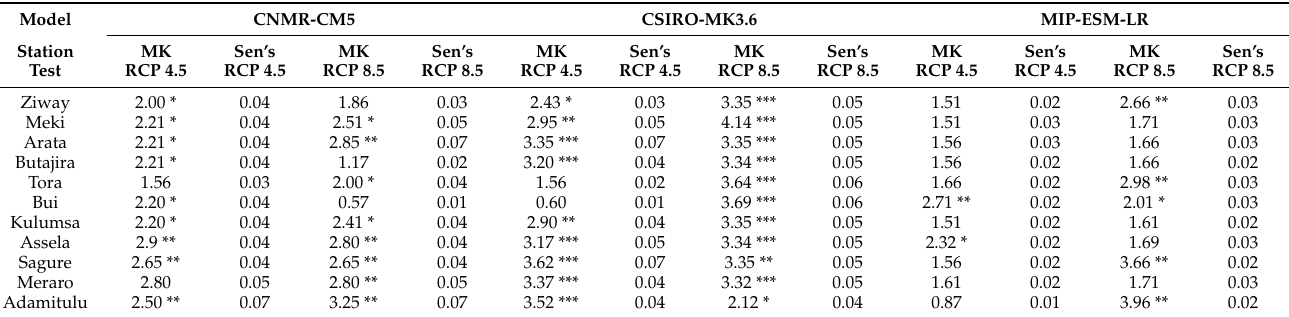
Table 4. Projected Mann–Kendall trend and Sen’s slope estimator results for annual mean T max for eleven stations within the Ziway Lake Basin for the period 2026–2049.